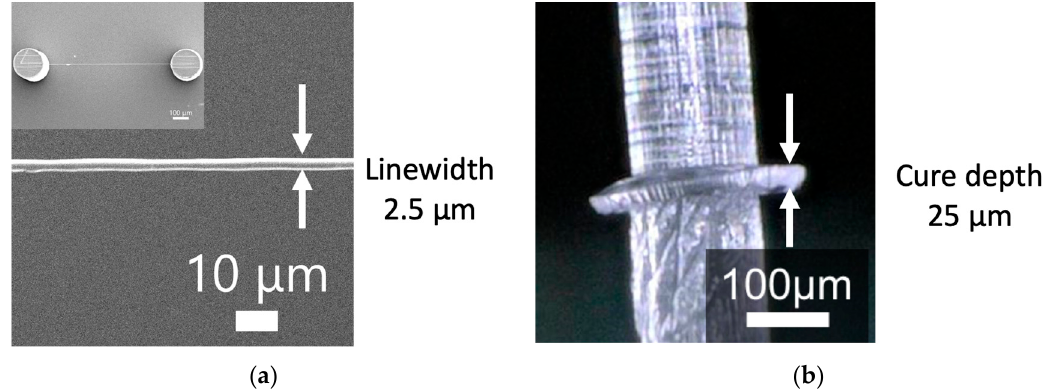
Figure 4. Minimum linewidth and cure depth: ( a ) Minimum width of the line structure; ( b ) minimum cure depth of the overhanging single-layer disk.